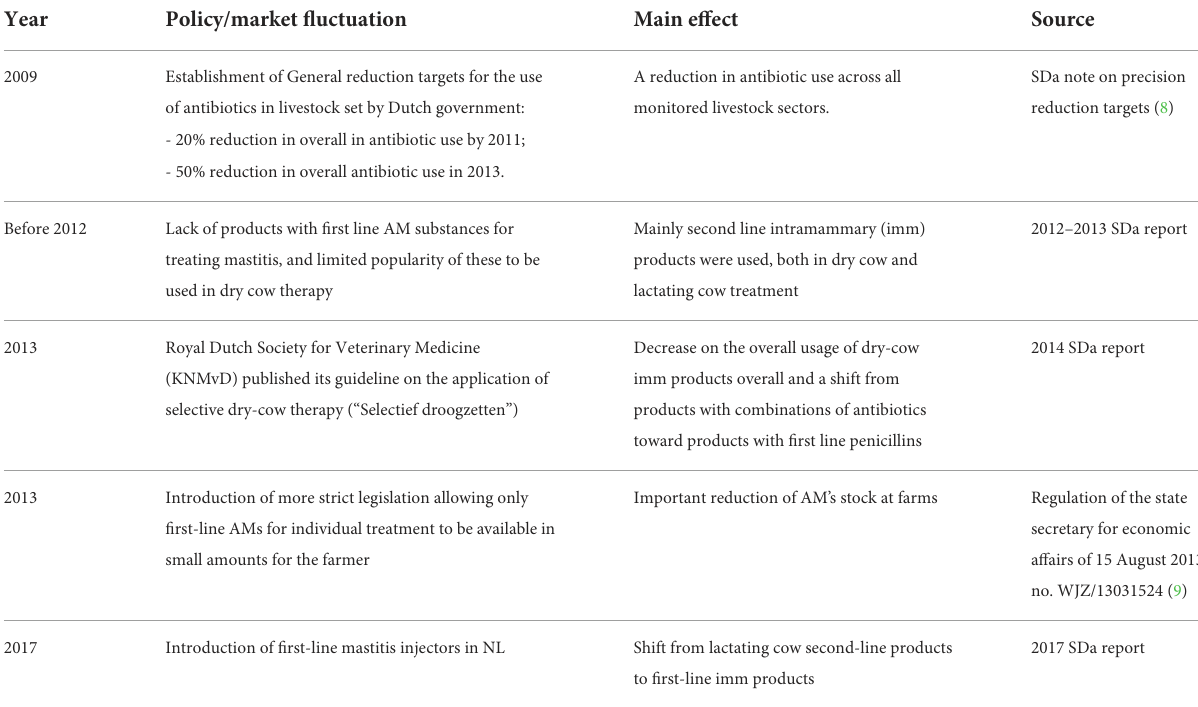
TABLE 1 Relevant policy and market fluctuations restricting the use of antimicrobials in the dairy sector in the Netherlands since